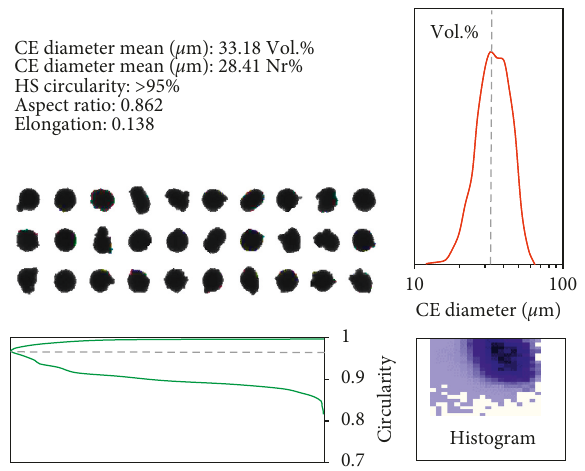
Figure 5: IN718 powder morphology